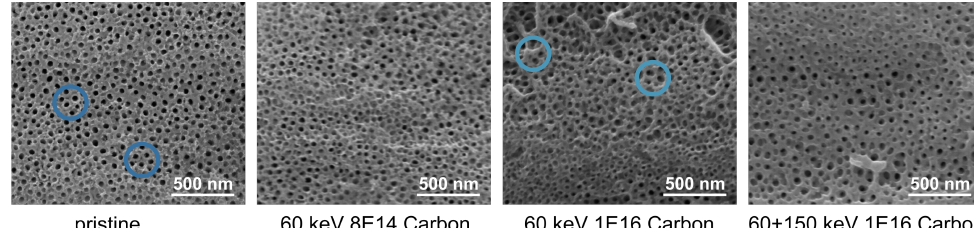
Figure 2. SEM images of NT arrays reveal surface relaxation effects upon ion bombardment with different C ion energies and fluences. Characteristic regions are highlighted with blue circles.